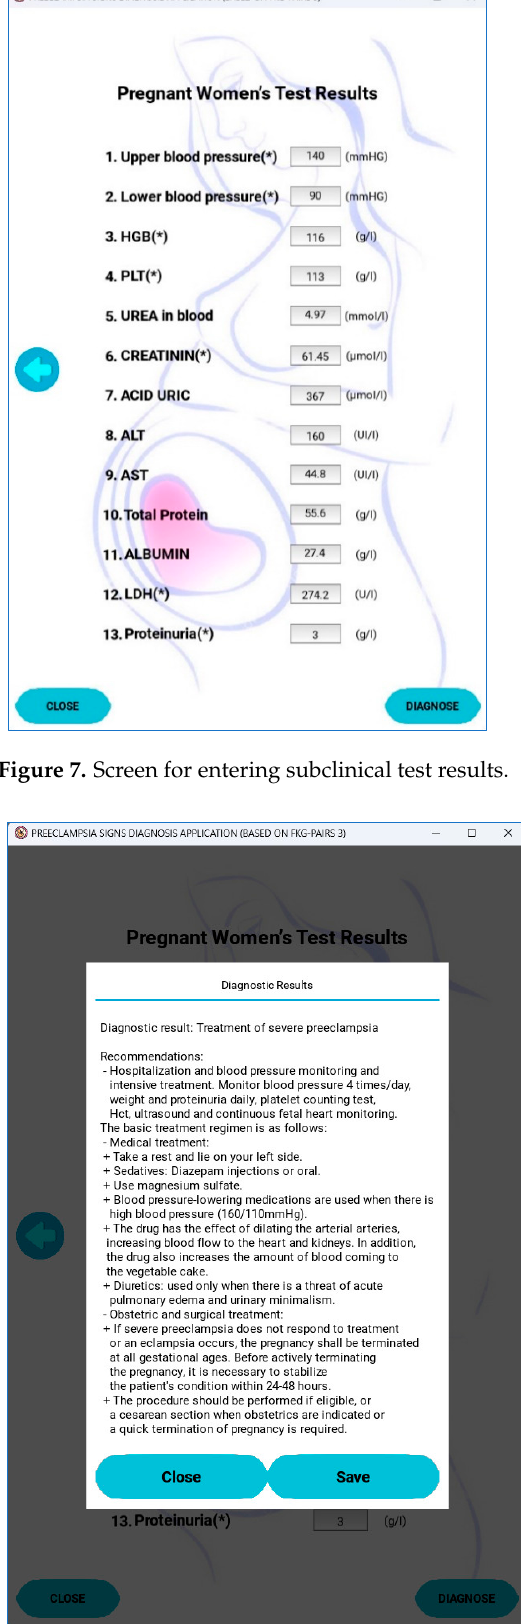
Figure 8. Diagnostic results screen and recommendations.